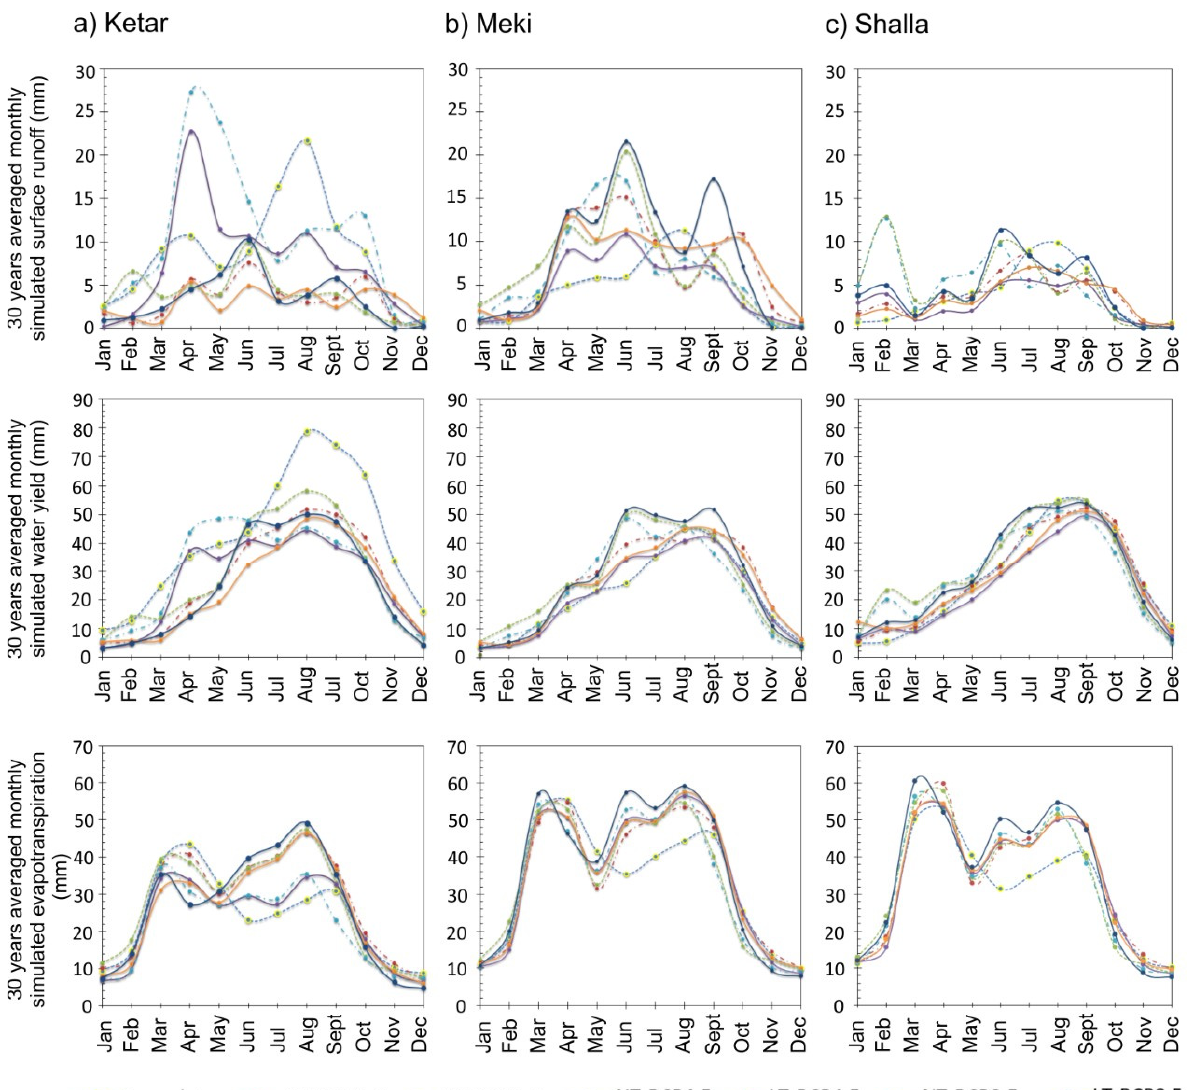
Figure 5. The simulated monthly distributions of Q, WY, and ET in the Ketar, Meki, and Shalla sub-basins for the applied climate scenarios. ( a ) Ketar, ( b ) Meki, ( c ) Shalla.